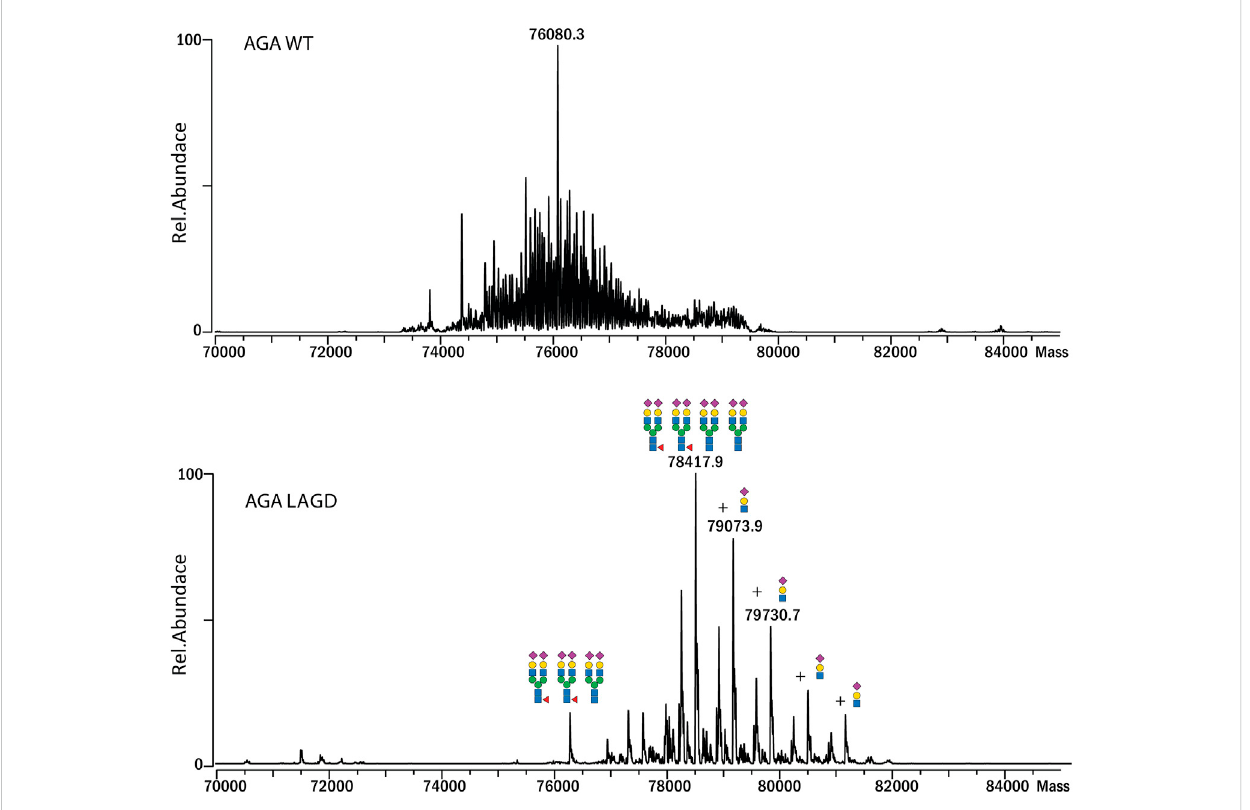
FIGURE 5 IntactMSanalysisofAGAWT/glycodesignatthenative conditions. Massdeconvoluted spectraofAGAWT(top)andAGALAGD (bottom)